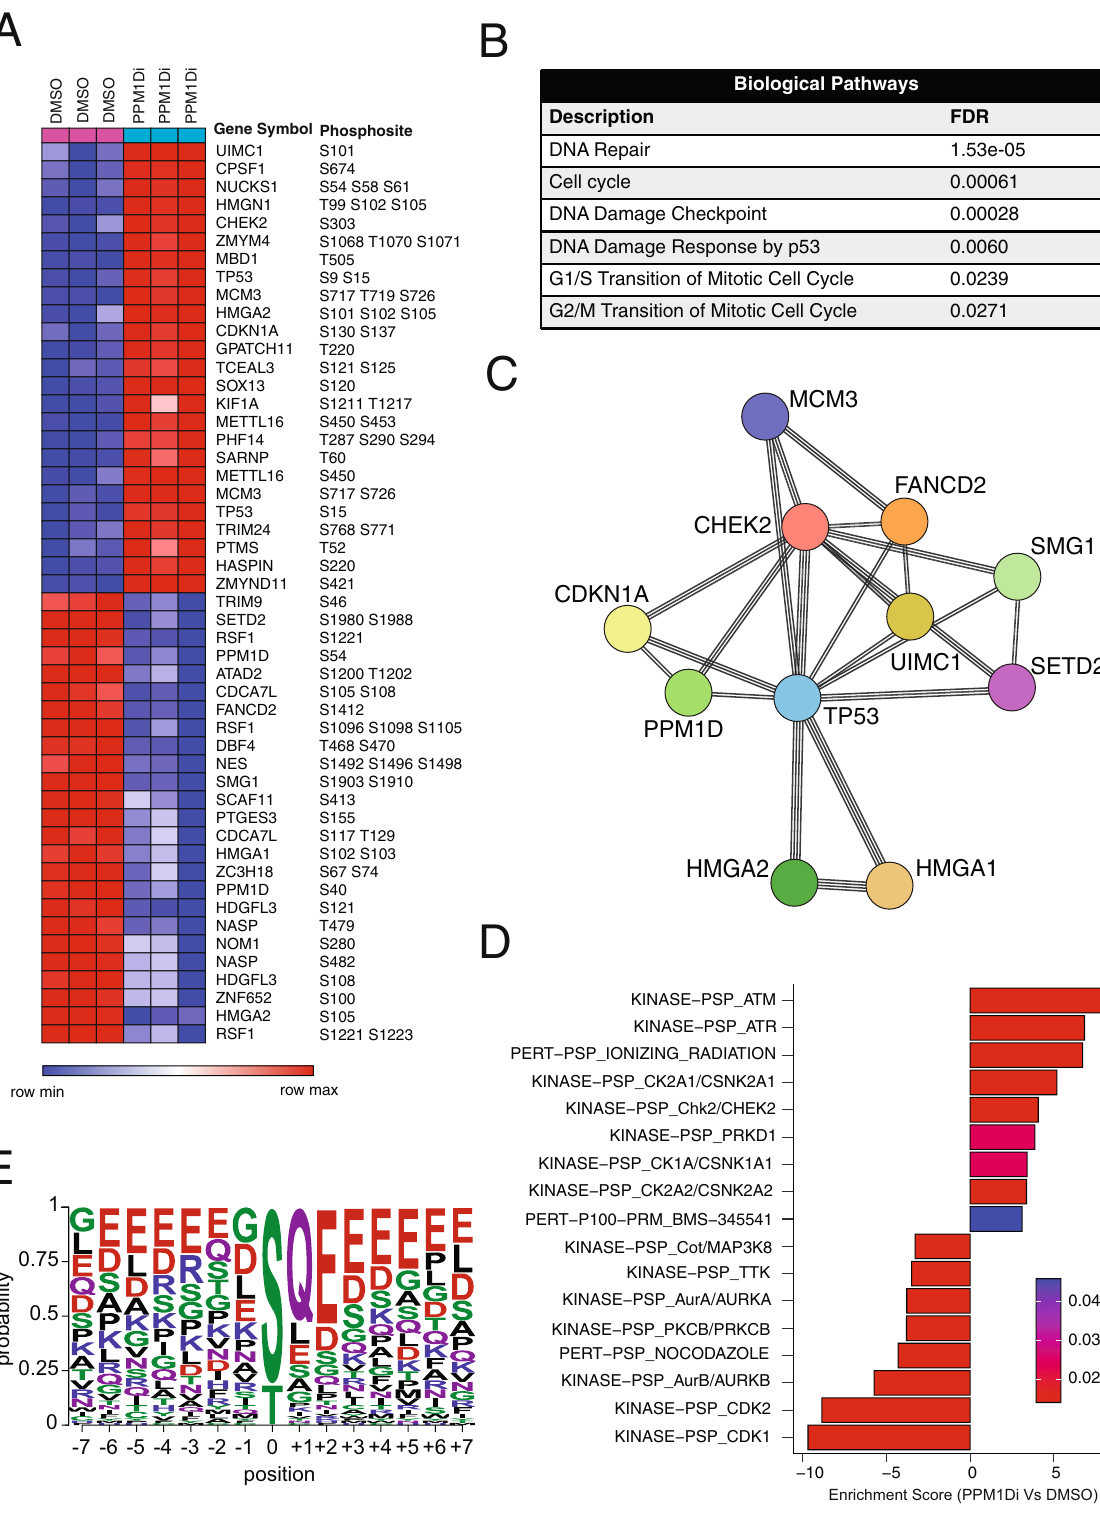
Supplementary Fig. 9A). PPM1D expression also correlated with MDM2 dependency across all cell lines (Supplementary Fig.